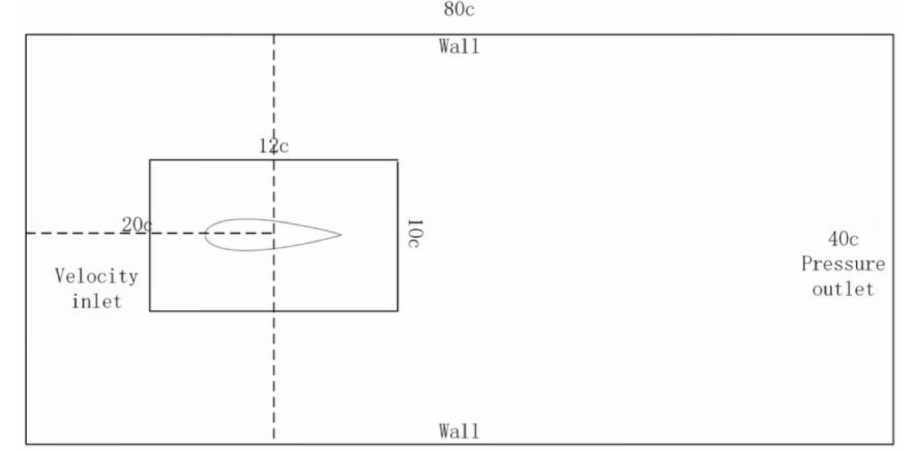
Figure 3. Calculation area.